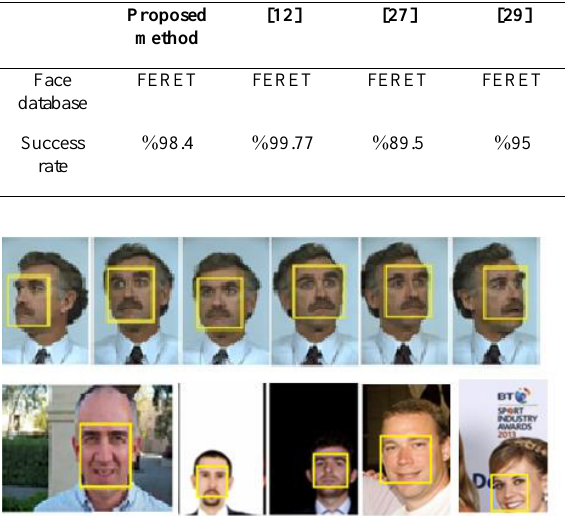
Table 3. Comparison between the results of the proposed and three other methods.